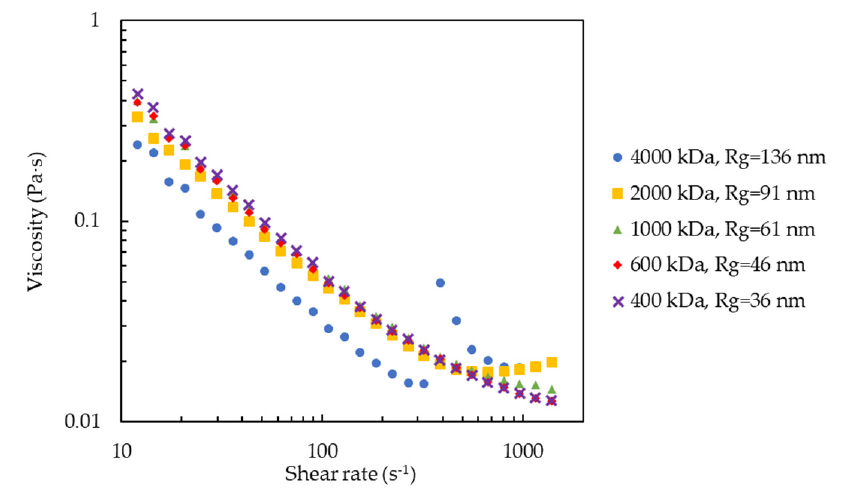
Figure 4. The viscosity of silica-PEO suspensions against shear rate at C p = 0.04 mg ∙ m − 2 . The silica concentration was fixed to 10 wt% ( h = 28 nm). The different symbols stand for different PEO molecular weights. In this condition, only the suspension with 2000 kDa and 4000 kDa PEO showed shear-thickening, meaning that they gelled. These results agreed with those in Figure 3, showing that the suspensions with R g above 91 nm gelled at h = 28 nm.